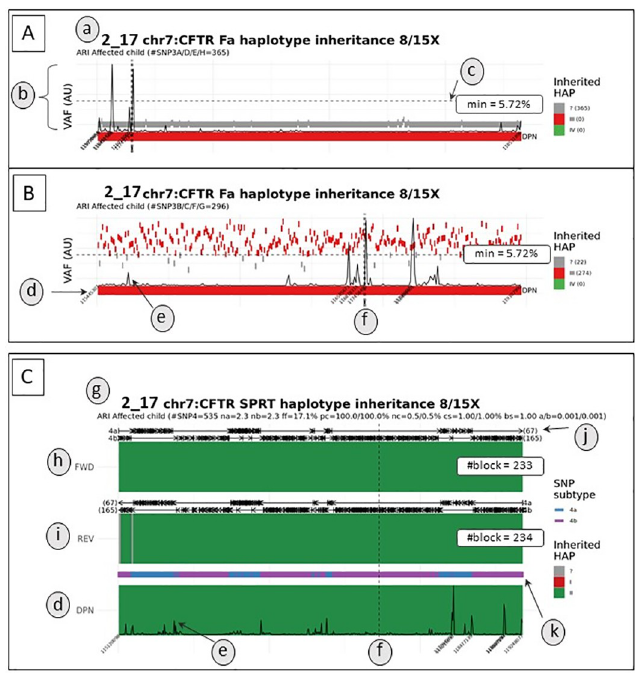
Fig 3. Example of a graphical result for autosomal inheritance in a family at risk of transmitting cystic fibrosis (family 2), subdivided into paternal (A, B) and maternal (C) inheritance. In this example, SNP3A/D/E/H correspond to SNP3 located on the “non-at-risk” paternal haplotype (A), while SNP3B/C/F/G correspond to SNP3 located on the “at-risk” paternal haplotype (B). “Non-at-risk” and “at-risk” haplotypes are shown in green and red, respectively. (a) For each result, the input data are summarized as follows: family ID, tested locus and parental inheritance, gDNA/cfDNA minimum sequencing depth, transmission mode (ARI = autosomal recessive inheritance, ADI = autosomal dominant inheritance, RXI = recessive X-linked inheritance) and number of SNP3. (b) Qualitative detection of fetal-specific SNPs with an allelic frequency (VAF) higher than our threshold visualized in (c) (AU = arbitrary units). SNP3A/D/E/ H from the “non-at-risk haplotype” were not detected in cfDNA (top), whereas the majority of SNP3B/C/F/G from the “at risk” haplotype were qualitatively detected above the background threshold (bottom). (d) Fetal genotype from sequencing of fetal gDNA obtained by invasive sampling (e) Plots of inter-SNP distance. Each peak indicates a longer genomic distance between two consecutive tested positions. (f) Location of the parental mutation, symbolized by a vertical dashed line. (g) Input data and quality parameters of the SPRT analysis, namely number of SNP4, mean number of SNPs 4 α or 4 β per block (na and nb), concordance between conclusive haplotype blocks in forward and reverse orientation (pc) and proportion of nonconclusive haplotype blocks (in gray) among all blocks (nc), and type I and type II statistical errors used in the SPRT test (a/b). (h) and (i) SPRT analysis in forward and reverse orientation, respectively. (j) Visualization of haplotype blocks, divided into 4 α (top) and 4 β (bottom) analyses, with number of conclusive blocks. (k) Distribution of SNPs 4 α (blue) and 4 β (purple) along the genomic